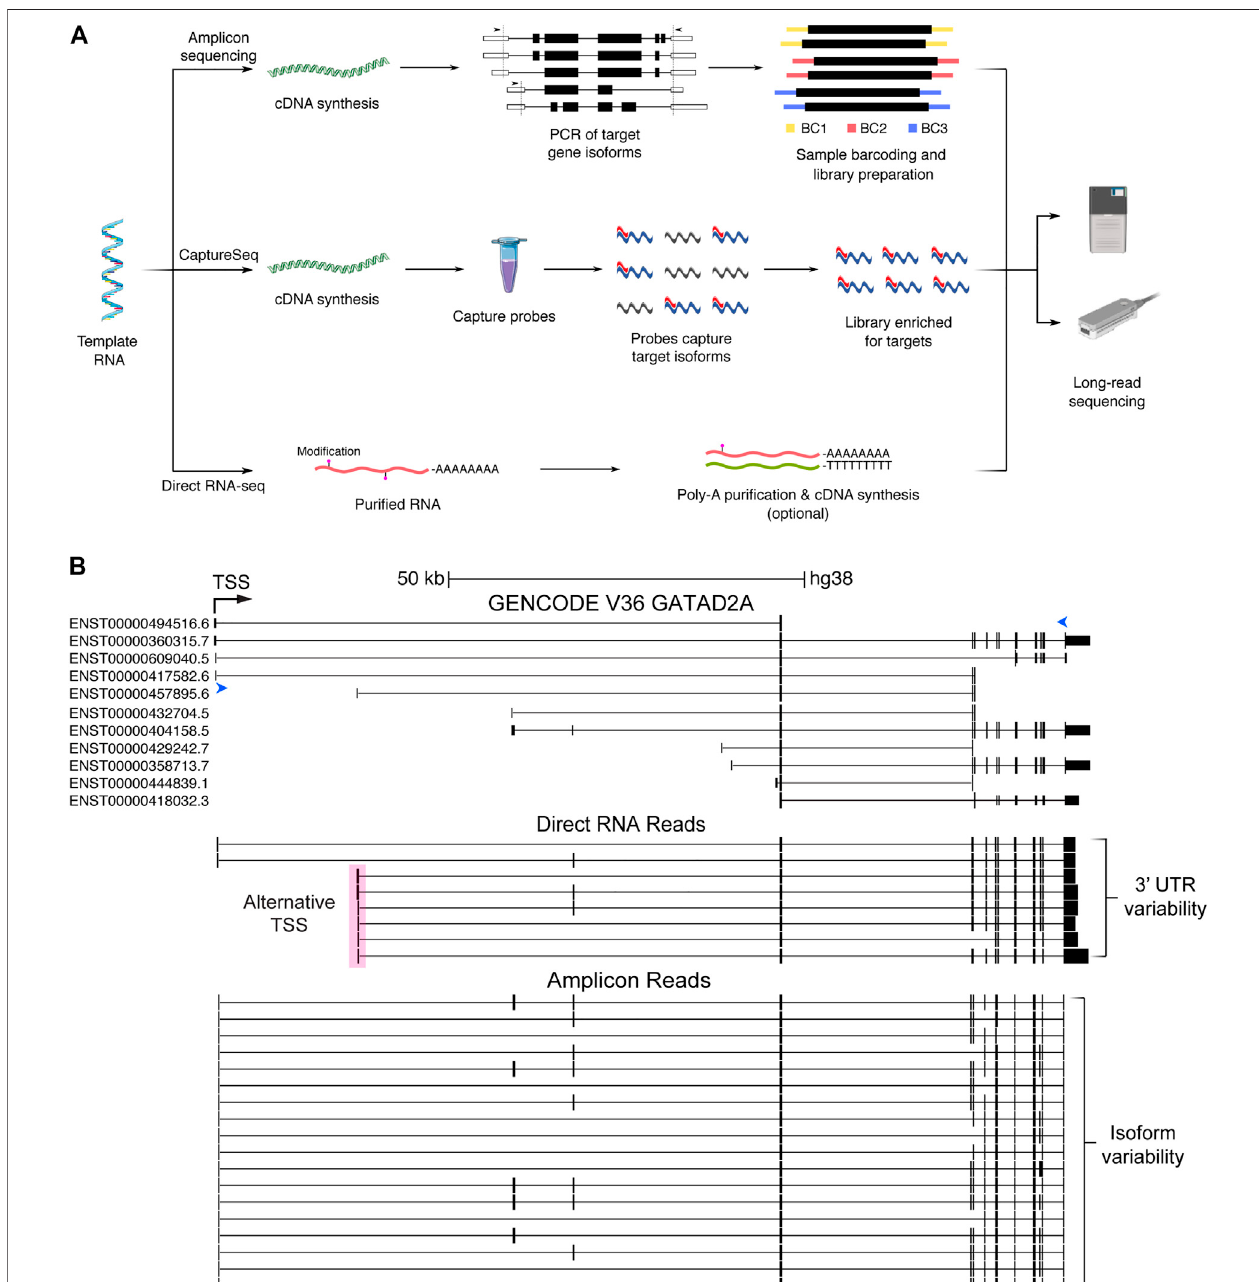
FIGURE2| Long-readsequencingmethodsand datagenerated. (A) Simpli fi edpathways describingthreelong-readsequencingmethods:ampliconsequencing, CaptureSeq and direct RNA sequencing. Amplicon sequencing involves cDNA synthesis followed by PCR of known and novel expressed isoforms from target genes (arrows indicate locations of forward and reverse primers). Sample barcodes can additionally be used for multiplexing before sequencing. CaptureSeq is performed on cDNAandutilisespoolsofoligonucleotideprobes(captureprobes).Probes(red)hybridisetoisoformsfromtargetgenes(blue),whichcanthenbepuri fi ed,creating a sequencing library highly enriched for target isoforms. Direct RNA sequencing requires puri fi ed RNA and commonly includes the optional preparation steps to purify polyA RNA (to remove ribosomal RNA) and perform cDNA synthesis (to break-up RNA secondary structures) respectively. Only the RNA strand is subsequently sequenced. (B) Schematic of isoform information generated by whole-transcriptome direct RNA sequencing vs gene-targeted amplicon sequencing of cDNA. Image from the UCSC Genome Browser of the schizophrenia risk gene GATAD2A (Ripke et al., 2014) , showing GENCODE annotations compared to nanopore direct RNA (middle) and amplicon (bottom) reads collapsed into high-con fi dence isoforms by FLAIR (Gleeson et al., 2020; Tang et al., 2020). Forward and reverse primers for amplicon sequencing are indicated by blue arrow heads. Transcriptional start site (TSS) shown by black arrow. An alternate start site (pink box) and 3 ′ UTR variants are captured by direct RNA sequencing of the SH-SY5Y cell line. At least fi ve supporting reads were required to identify high-con fi dence isoforms from direct RNA sequencing. A large number of additional isoforms are supported by amplicon sequencing using a more stringent threshold of 500 supporting reads. CDS, coding sequence; BC,